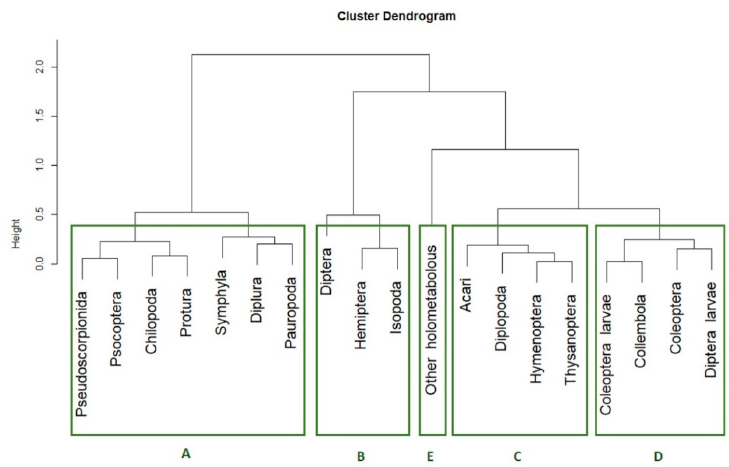
Figure 3. Dendrogram of hierarchical cluster analysis of taxa based on NMDS results. The five clusters are highlighted in green. Group A included the largest number of taxa and specifically the Pseudoscorpionida, Psocoptera, Protura, Diplura Chilopoda, Symphyla and Pauropoda. Group B was made up of Diptera, Hemiptera and Isopoda taxa, while the larval form of Diptera was located in group D, together with Coleoptera, both as larvae and other biologic forms, and Collembola. The Acari,